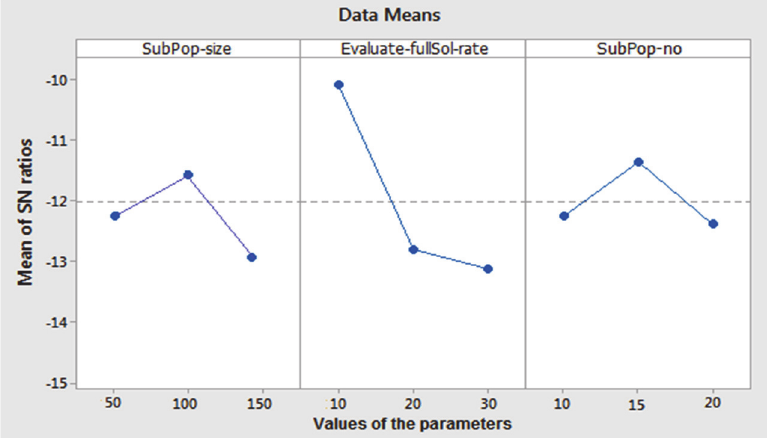
Figure 2. Graphical results of the Taguchi method for BBA CO algorithm.